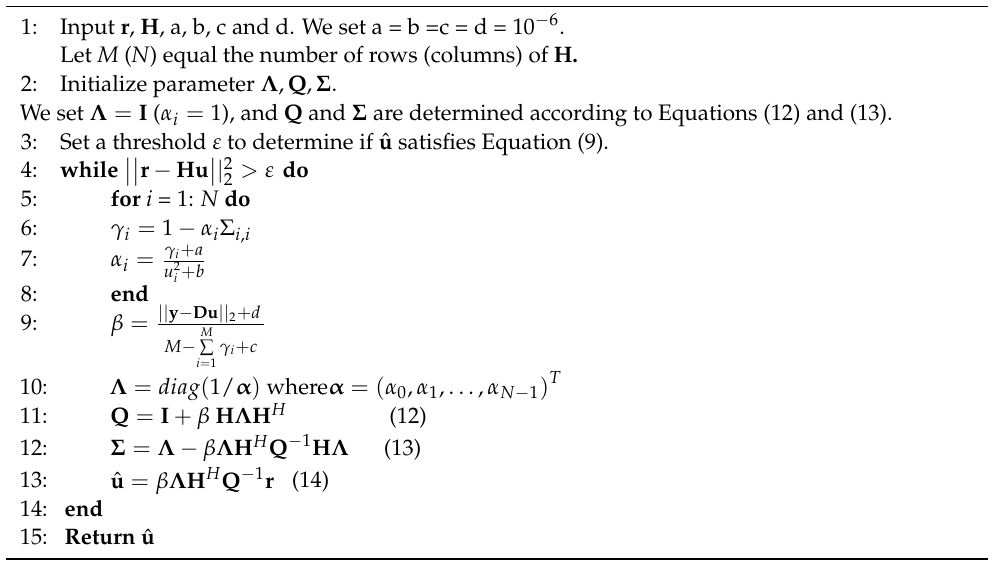
Algorithm 1 Sparse Bayesian Learning (SBL